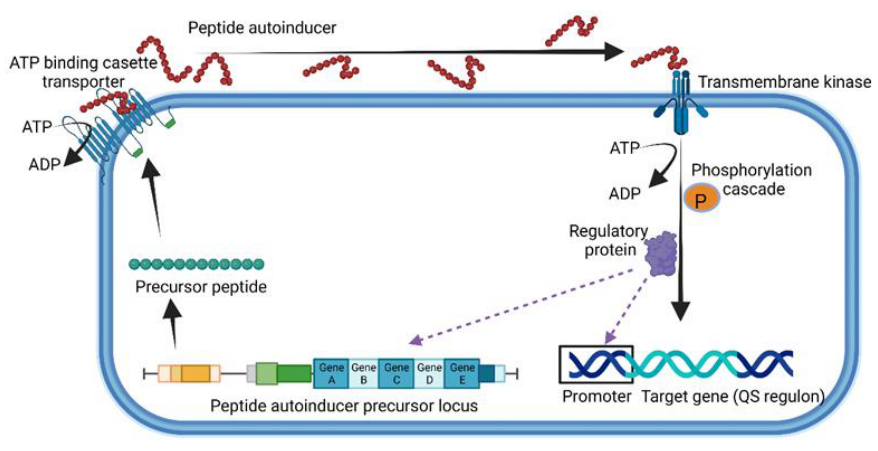
Figure 2. General representation of quorum sensing used by Gram-positive bacteria. This illustration was constructed using BioRender (https://biorender.com/, assessed on 1 September 2022).